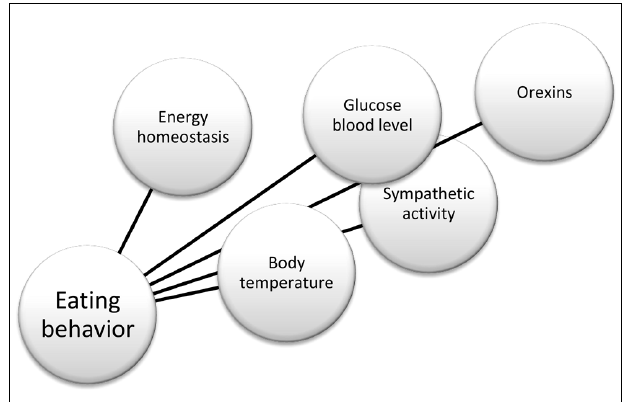
FIGURE 2 | Factors influencing eating